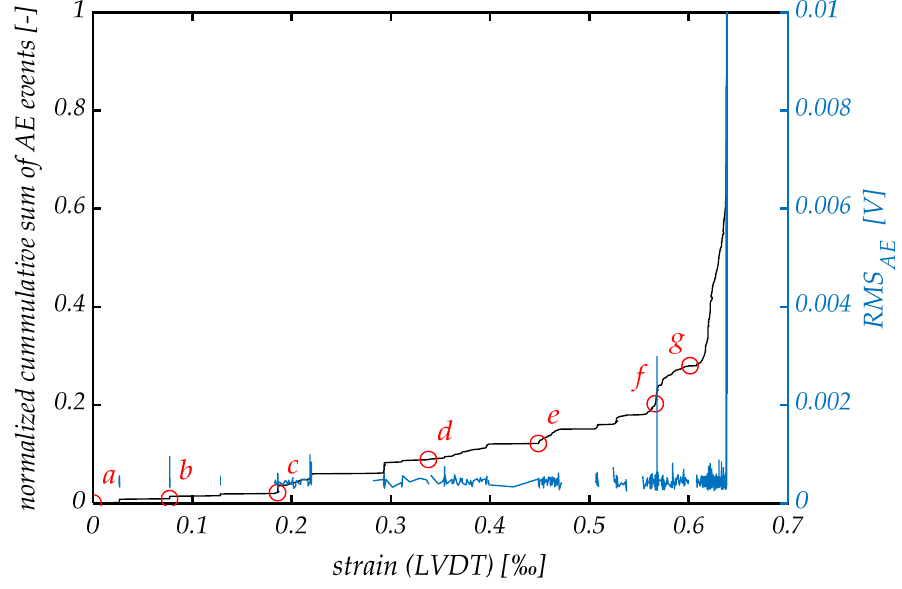
Figure 14. AE signal’s characteristics, the normalized cumulative sum of AE events and RMS AE . Red circles ( a – g ) indicate the different stages in Figure 13.